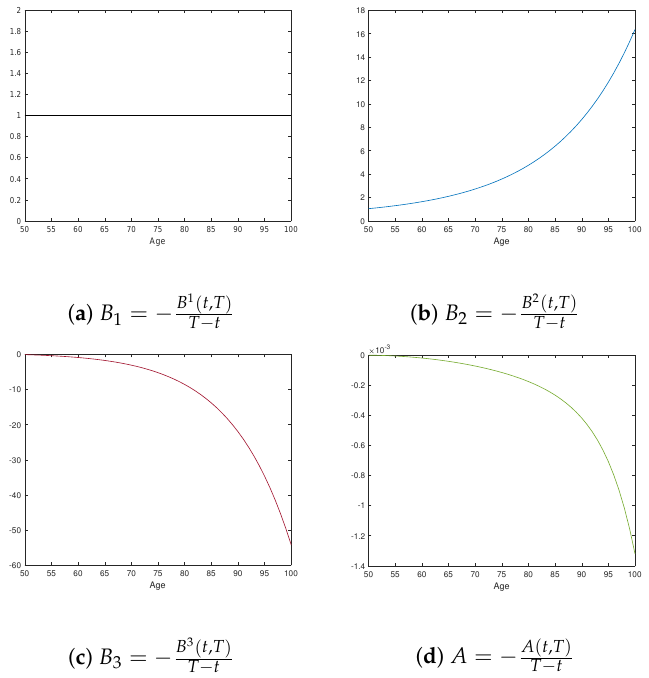
Figure 4. Factor Loadings in the Independent AFNS